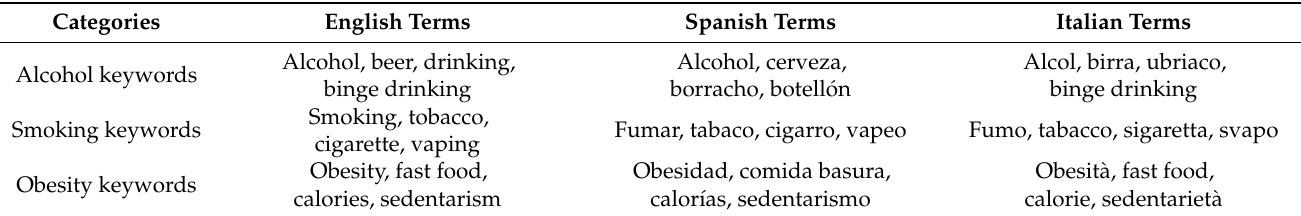
Table 1. Specific language terms used for country